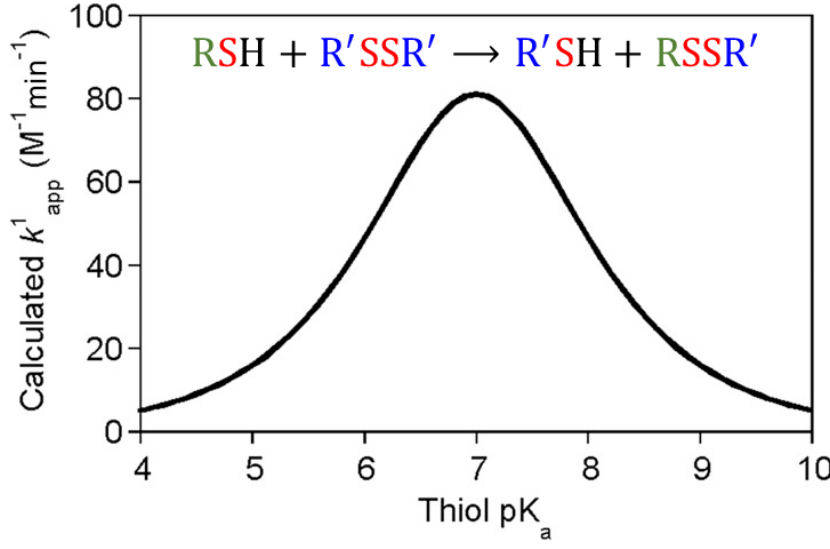
Figure 4. Calculated apparent rate constant for thiol-disulfide exchange in a solution at pH 7 as a function of reactant thiol pKa Reprinted with permission from [7]. Copyright Mary Ann Liebert, Inc.